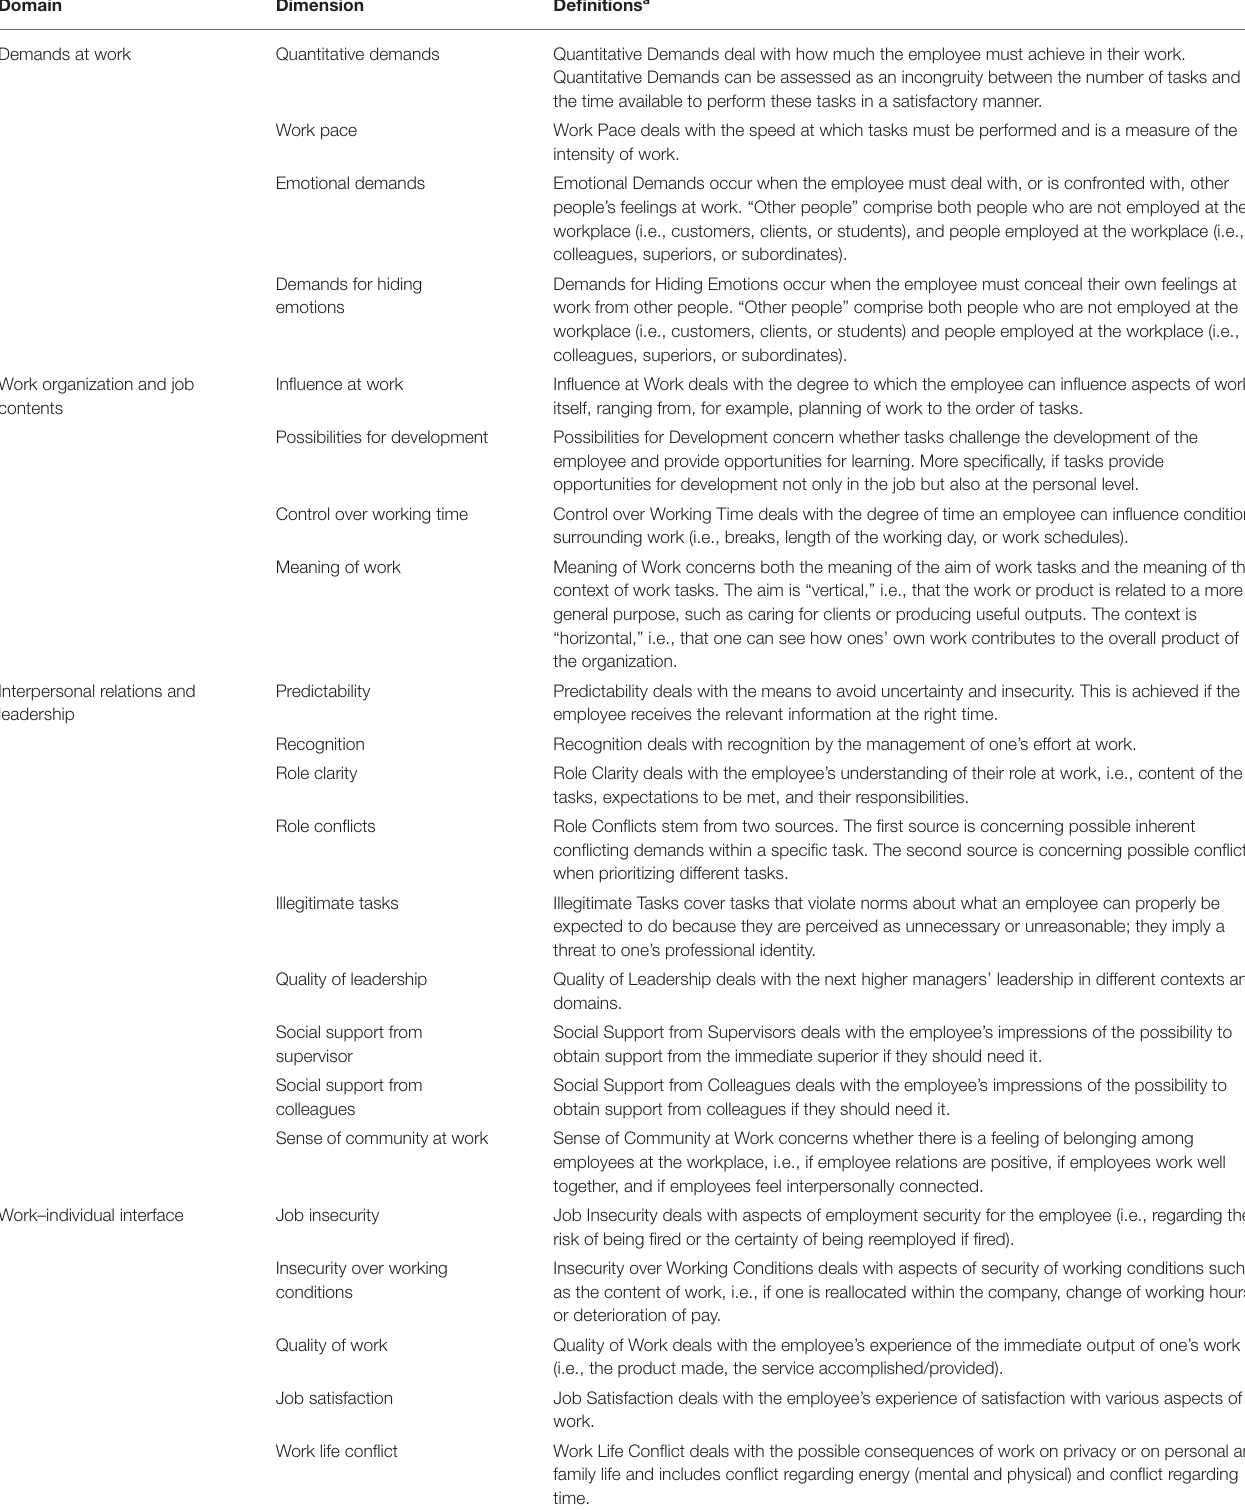
TABLE 1 | Definitions of the 32 dimensions within the 6 COPSOQ-III domains.